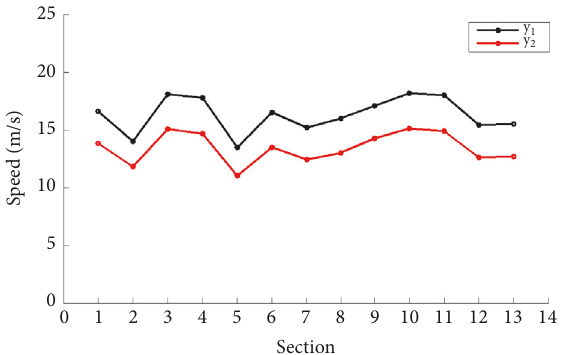
Figure 1: The trend of polyline 𝑦 1 and polyline 𝑦 2